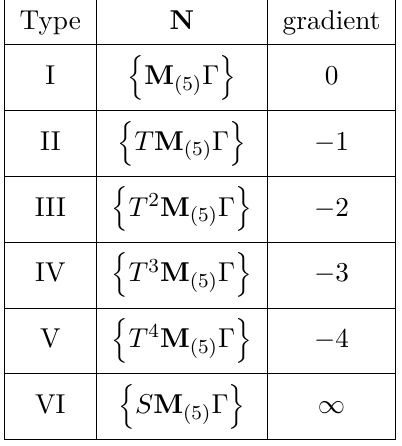
Table 6 . Types for D = 5